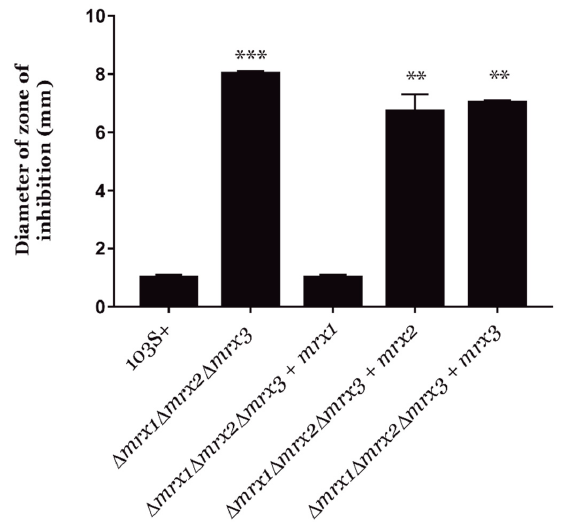
Figure 3. DETA NONOate susceptibility test. Analysis of the susceptibility to the oxidative agent DETA NONOate of the triple R. equi ∆ mrx1 ∆ mrx2 ∆ mrx3 mutant and its mrx -complemented